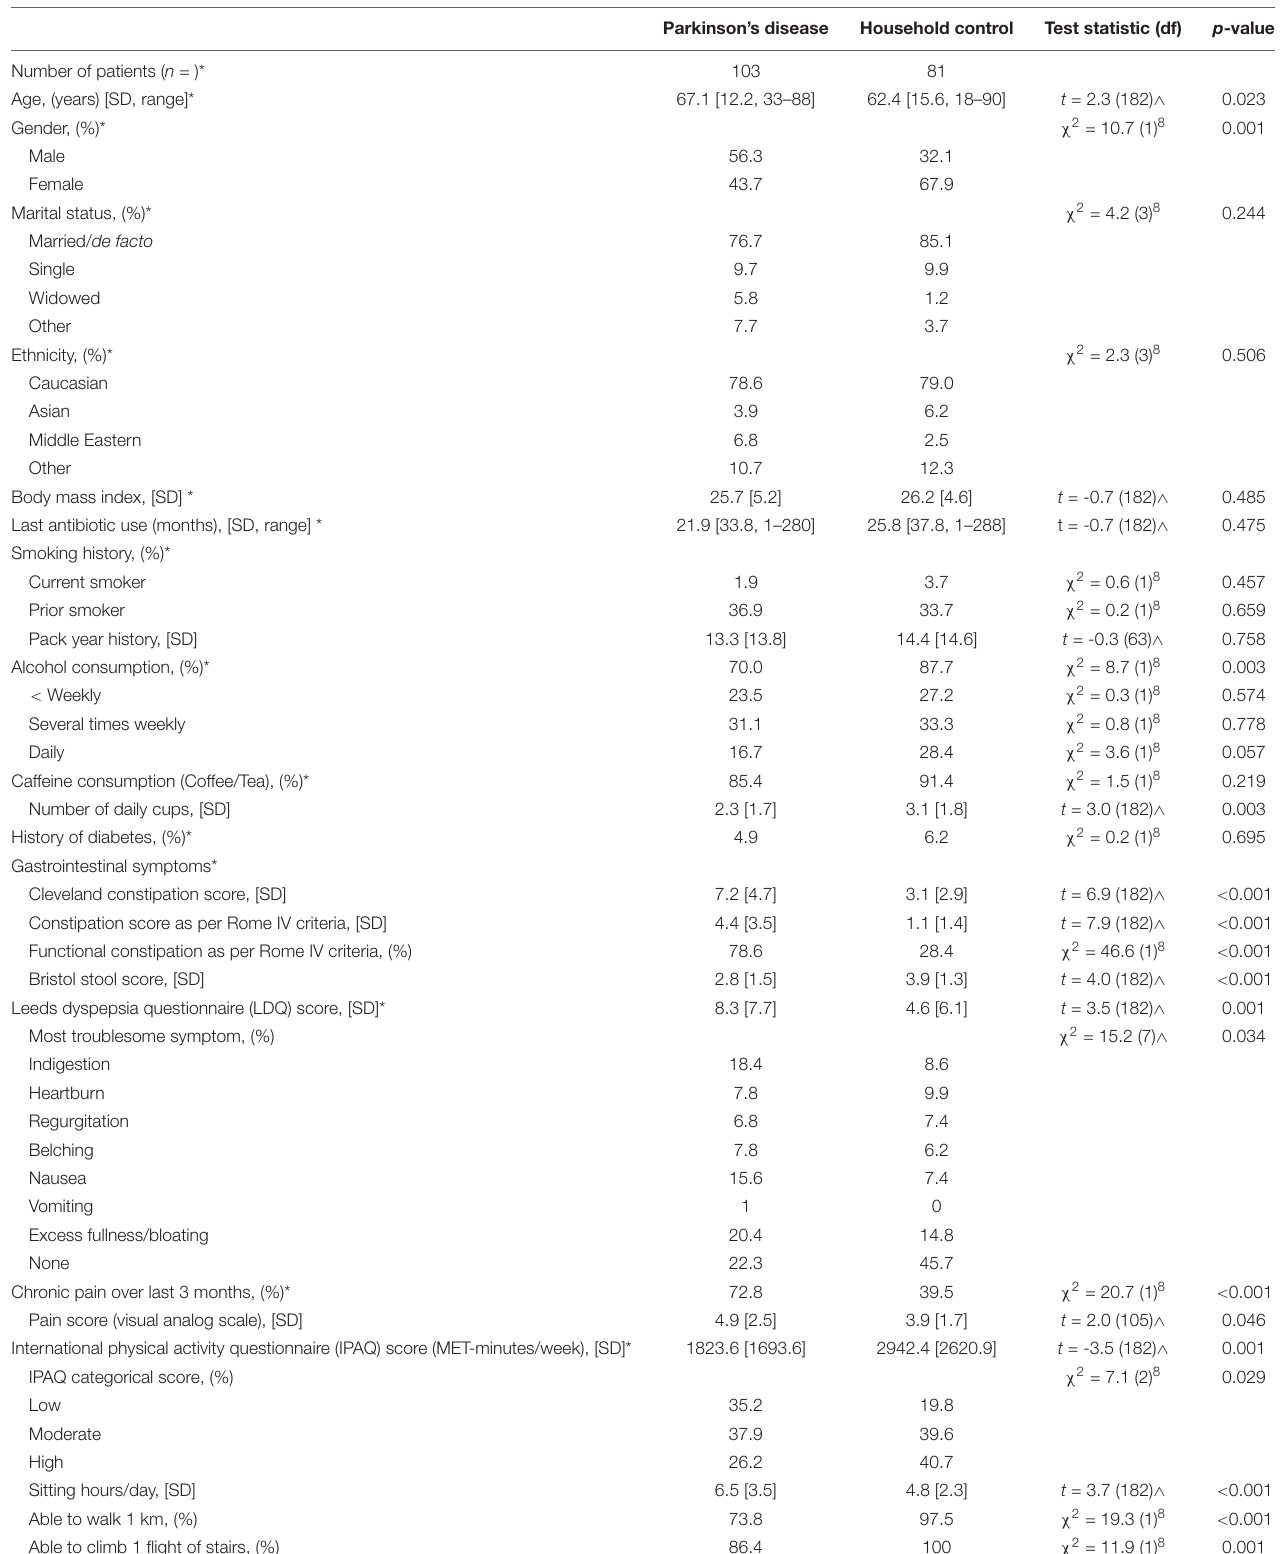
TABLE 1 | Cohort demographic and clinical characteristics.